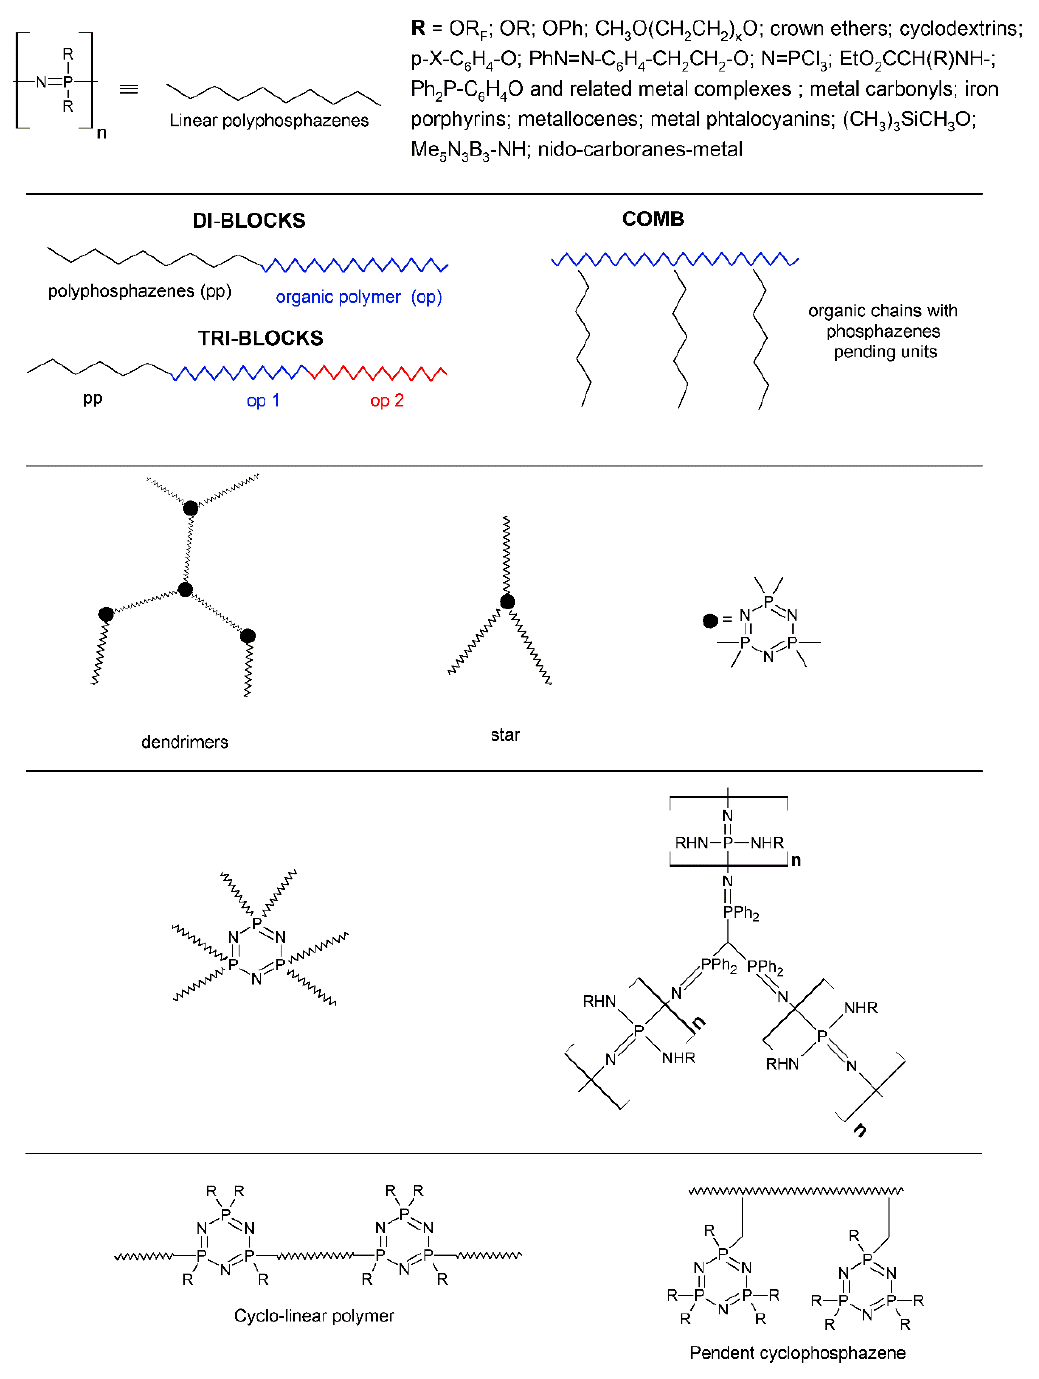
Figure 1. The different frameworks of the P=N backbone. The availability of a wide range of organic substituents on the -P=N-skeleton also allows the achievement of different 3D architectures in supramolecular arrangements, from electrospun scaffolds [36] to micelles and polymersomes [37], when amphiphilic moieties are bonded to the P atoms or through noncovalent interactions (Figure 2)